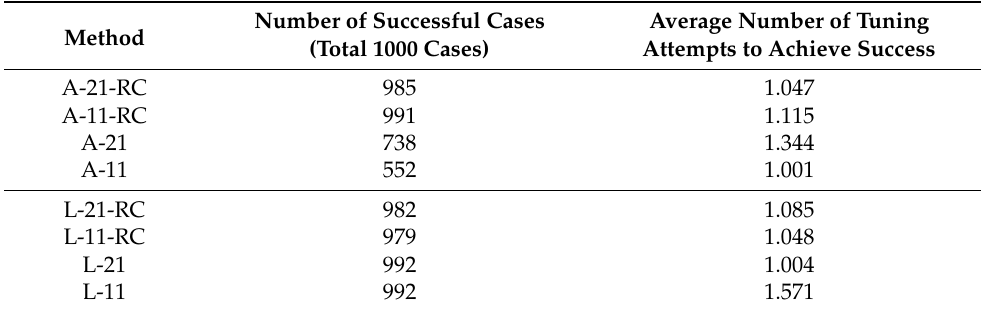
Table 3. Number of successful cases and average number of tuning attempts to achieve success using eight methods after training 10 million